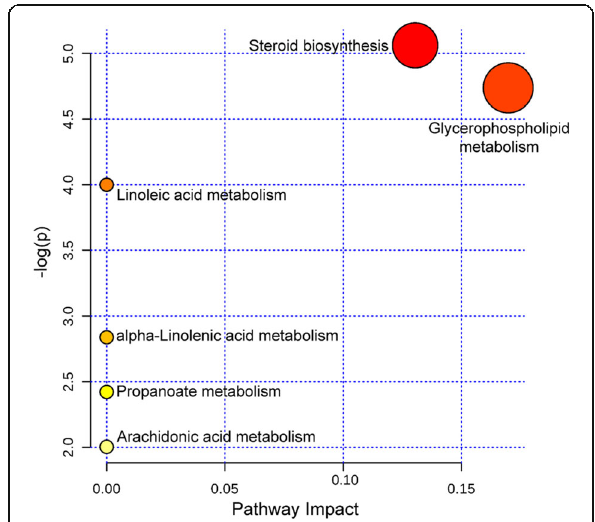
Fig. 9 ICA-induced metabolic pathway perturbations by MetaboAnalyst V. 4.0. Each circle dot represents one metabolic pathway. Circle size and circle color were based on the pathway impact value and P -value,